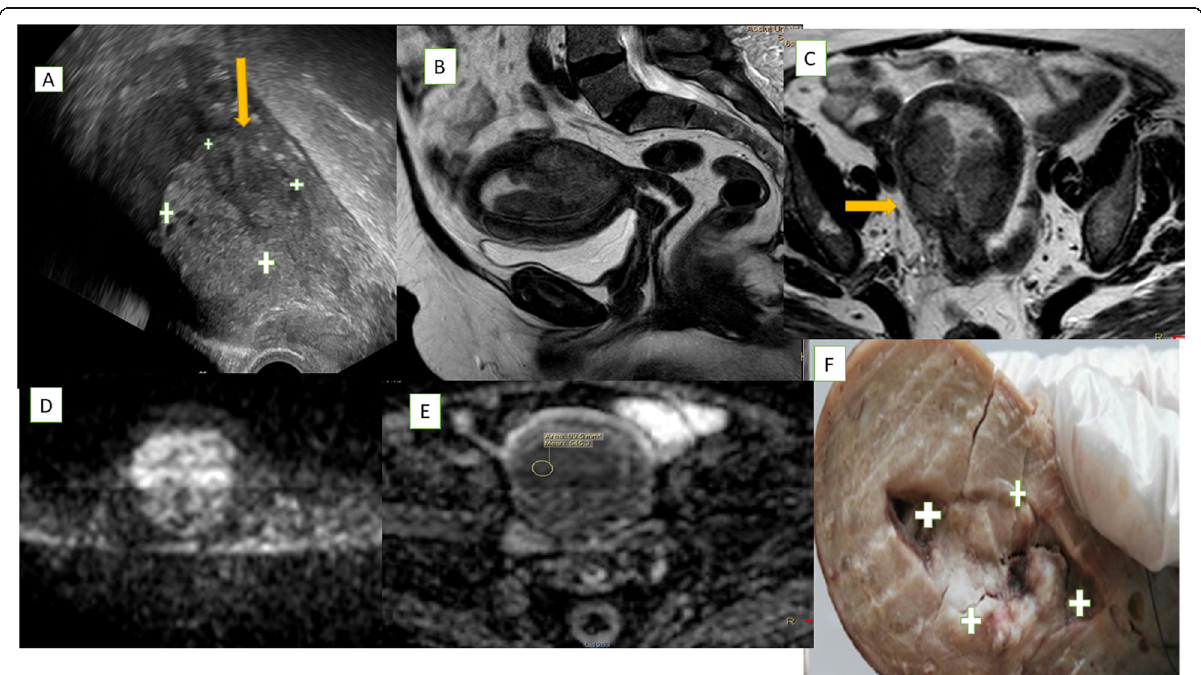
Fig. 3 Post-menopausal female aged 66 years old, presented with PMB. Sonohysterography image ( a ) showed an irregular endometrial focal mass lesion with disruption of the endometrial myometrial interface (arrow) which was considered suspicious of malignancy be both observers. Sagittal T2WI ( b ) and axial T2 WI ( c ) showed an irregular sessile lesion occupying most of the endometrial cavity extending into the internal cervical OS and infiltrating the junctional zone in the right lateral uterine wall with thinned out myometrium and myometrial infiltration more than 50% (arrow), no parametrial infiltration. DWI at b 1000 s/mm 2 ( d ) lesion showed high signal intensity. ADC map ( e ) ADC value measures